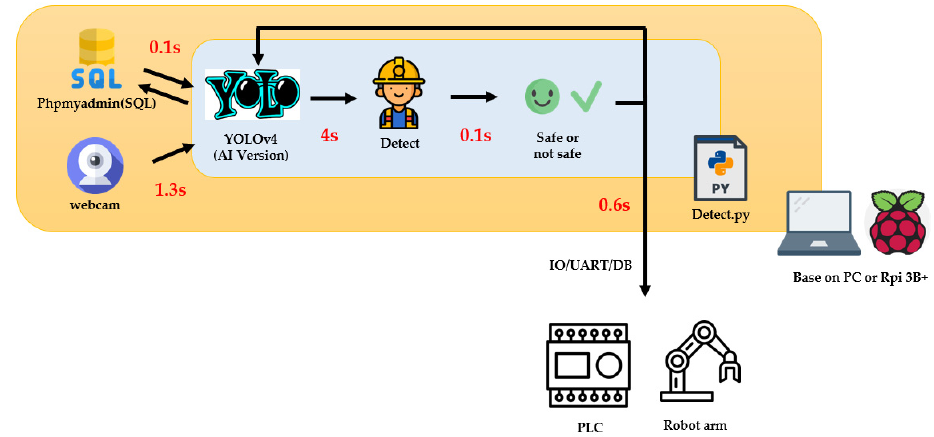
Figure 29. AI working area safety module system architecture.